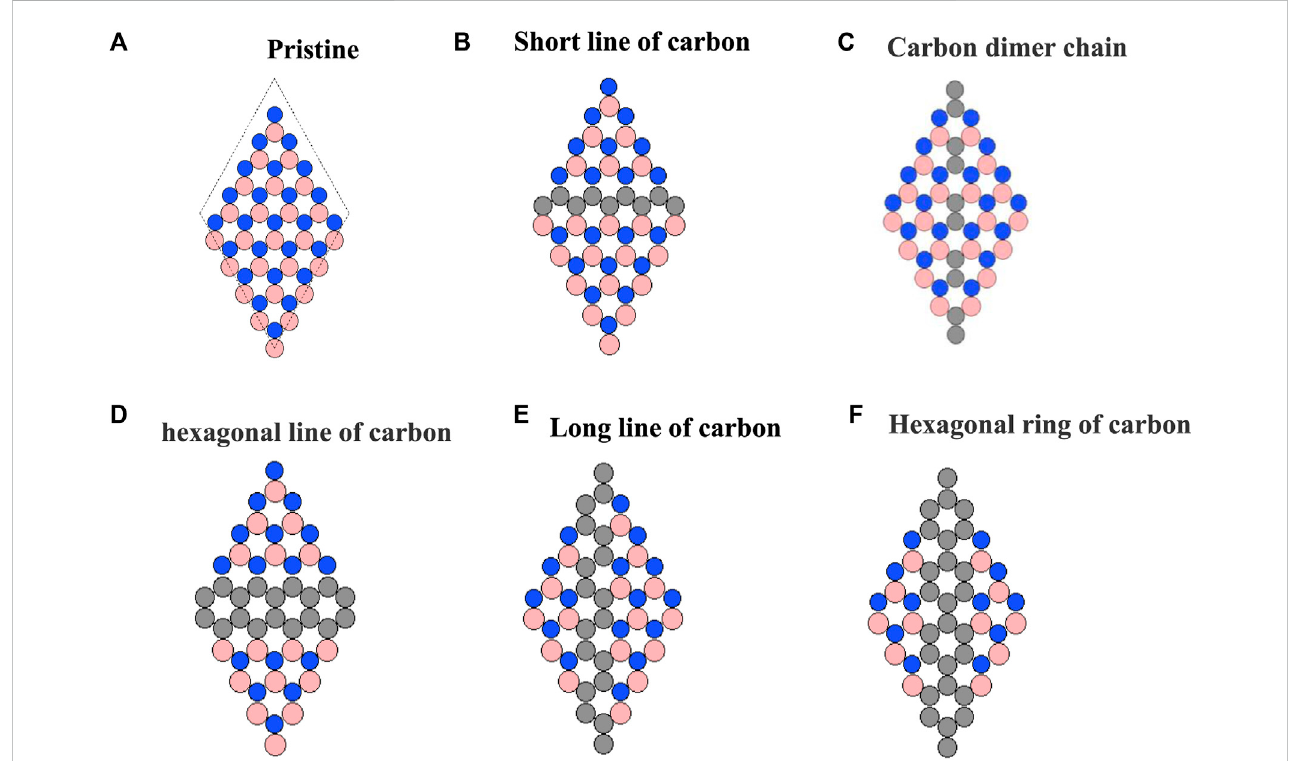
FIGURE 2 Different structures of the local atomic network geometry of the carbon nanoline-embedded hexagonal boron nitride monolayer showing the pristine monolayerstructure (A) andthecarbonnanolineconducting channelembedded withinthesemiconductingPML asashort lineofcarbon (B) , acarbondimer chain (C) , a hexagonal line of carbon (D) , a long line of carbon (E) , and a hexagonal ring carbon (F)